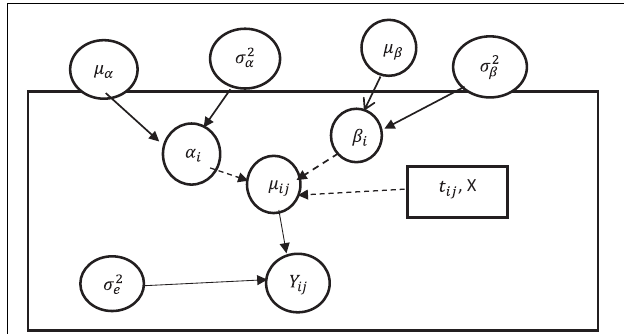
FIGURE 1 | A varying intercept and slope model (Bayesian